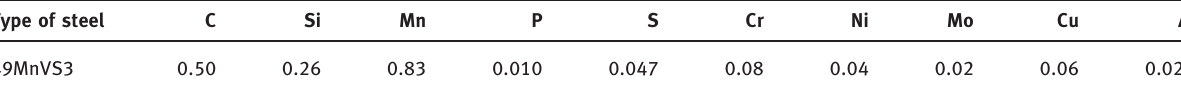
Table 1: Chemical composition of 49MnVS3 non-quenched and tempered steel. Type of steel